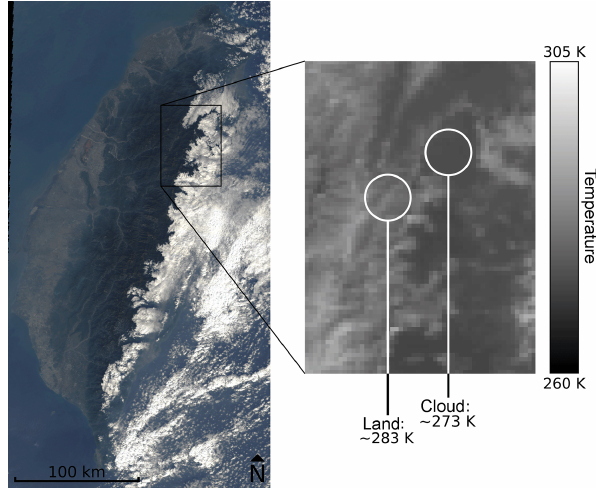
Figure 2. Surface temperatures calculated using a split-window ap- proach by Jiménez-Munõz and Sobrino (2008) for the MODIS over- flight on 5 January 2014 at 10:35UTC + 8. The emissivity for the land surface has been taken from the MODIS MOD 11 product. For clouds an emissivity of 1 has been assumed (cf. Sect.